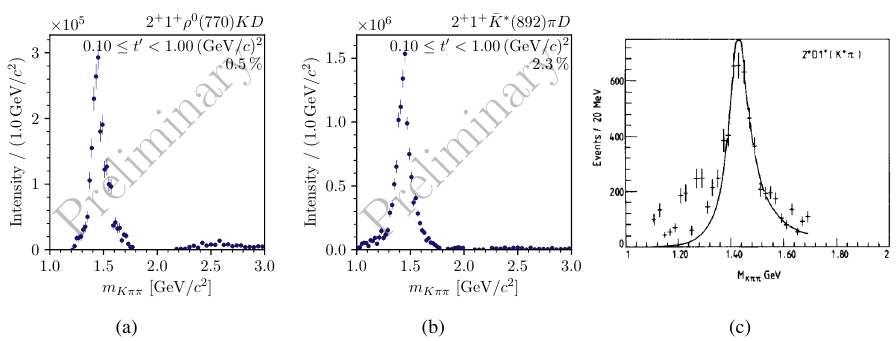
Figure 3: Intensity distributions of partial waves with J P = 2 + . (a) and (b) show the intensity distributions of the 2 + 1 + ρ (770) K D and 2 + 1 + K ∗ (892) π D waves from our analysis in the range 0 . 1 ≤ t (cid:48) < 1 . 0 (GeV / c ) 2 . The percentage numbers in the upper-right corners of (a) and (b) give the relative intensity of the corresponding wave. (c) shows the intensity distribution of the 2 + 1 + K ∗ (892) π D wave as obtained in the analysis of WA03 data performed by the ACCMOR collaboration [10] in the range 0 . 05 ≤ t (cid:48) ≤ 0 . 7 (GeV / c ) 2 . The curve represents a resonance model that was fitted to the